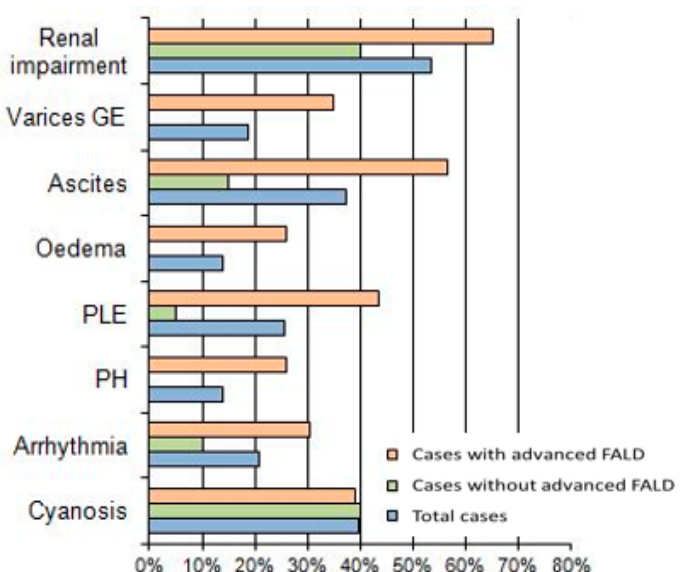
Figure 1. Comparison of signs and symptoms correlate to failing Fontan between cases defined with or without advanced FALD.